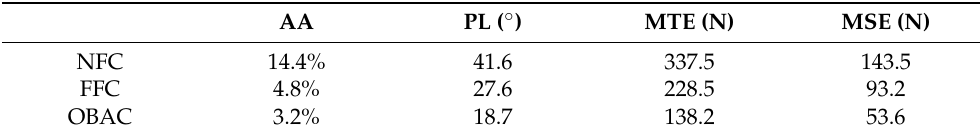
Figure 6. Dynamic loading experiment results with different control methods. Table 3. Performance indexes at dynamic loading experiment.